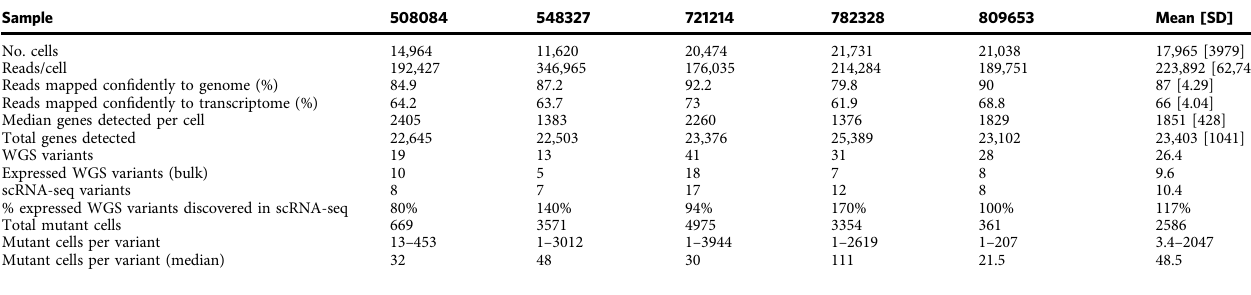
Revised Table 1. Overview of mutation discovery and detection in eWGS and scRNA-seq